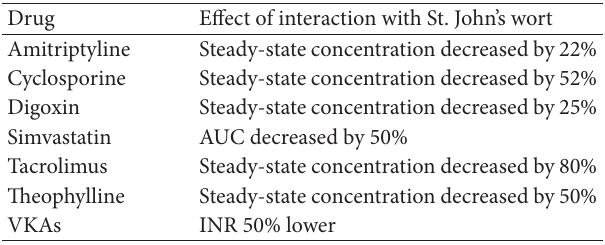
T 2: Clinically relevant drug interactions with St. John’s